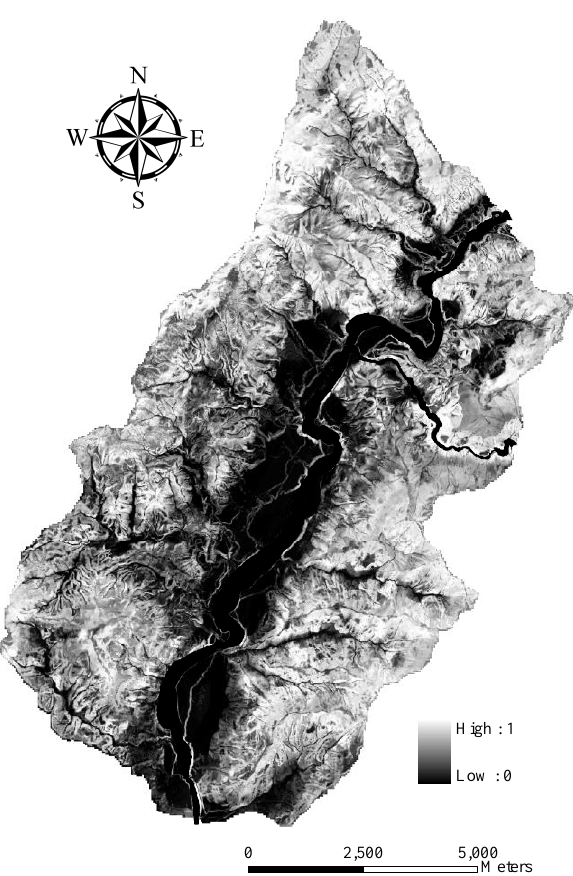
Figure 4. The preliminary landslide susceptibility